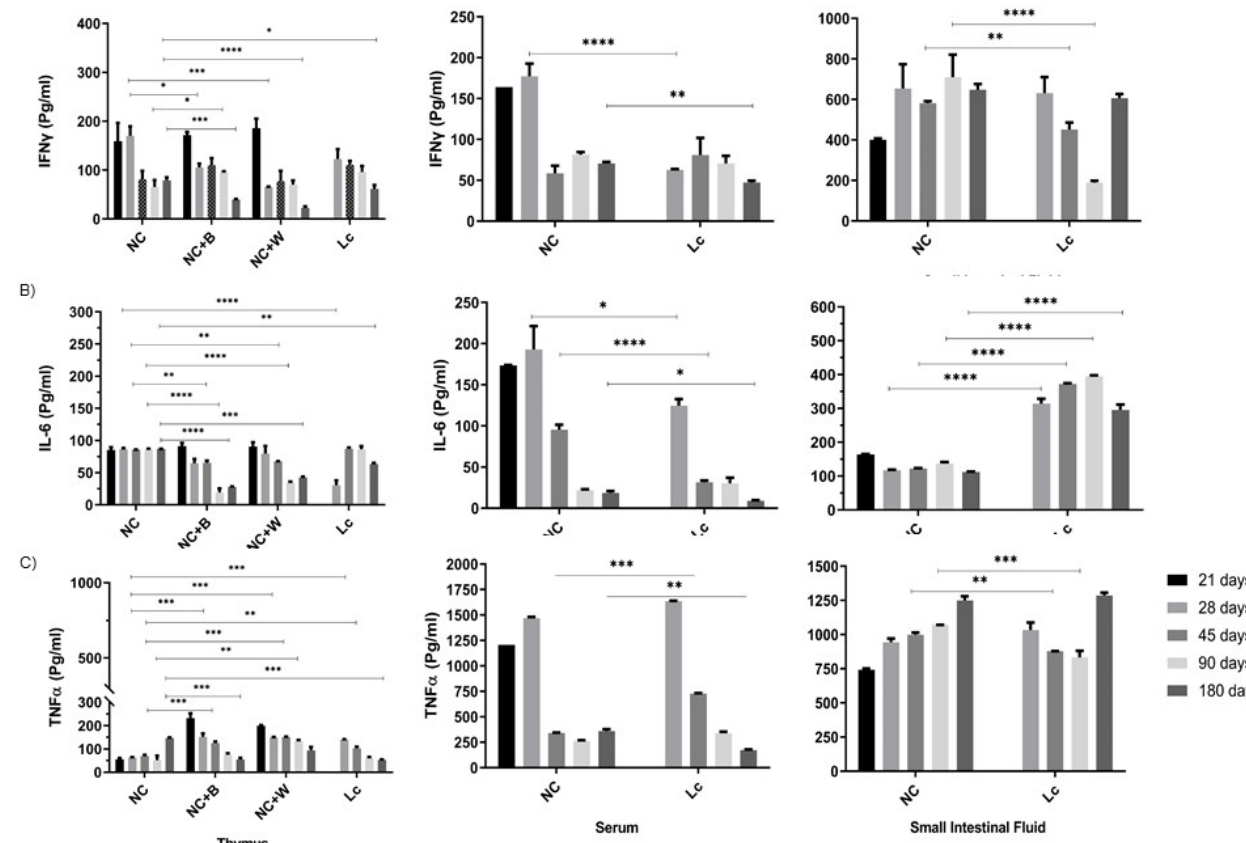
Figure 6. Cytokine production in the senescence mouse model. Levels of ( A ) IFN- γ ; ( B ) IL-6; ( C ) TNF- α were determined in the thymus, serum and small intestinal fluid from mice at different ages (21, 28, 45, 90 and 180 days) . Thymocytes were in vitro stimulated with the probiotic bacterium (B) or the probiotic cell wall (W), and the cytokines (IFN- γ , IL-6 and TNF- α ) were determined in the supernatant collected after 24 h of incubation. Data were shown as mean ± SD of 3 independent experiments with 3 mice per group. One-way ANOVA with Tukey’s correction for multiple comparisons. * p < 0.05; ** p < 0.01; *** p < 0.001; **** p < 0.0001. In serum, a decrease in IL-10 was also observed in older animals; however, in this By contrast, intestinal fluids showed high levels of these cytokines in old mice upon case, the probiotic supplementation had no effect (Figure 7A). A positive effect was ob- probiotic or probiotic cell wall stimulation (Figures 6 and served in the thymus and spleen with increases in IL-10 secretion upon the probiotic bac- teria or cell wall stimulation (Figure 7A).